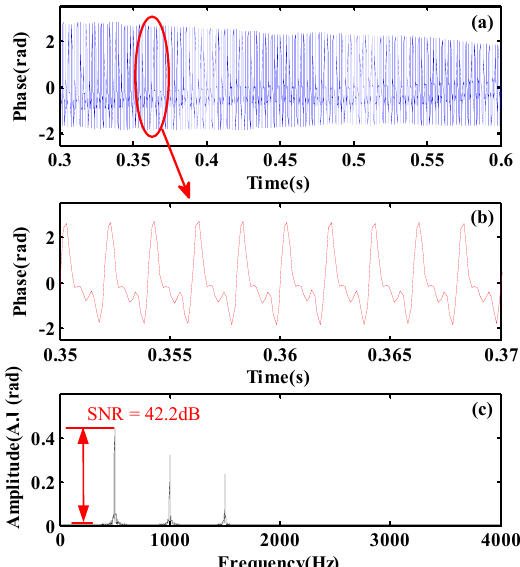
Figure 13. ( a ) Filtered phase curve and ( b ) its partial enlargement, ( c ) the frequency spectrum of the filtered phase curve.